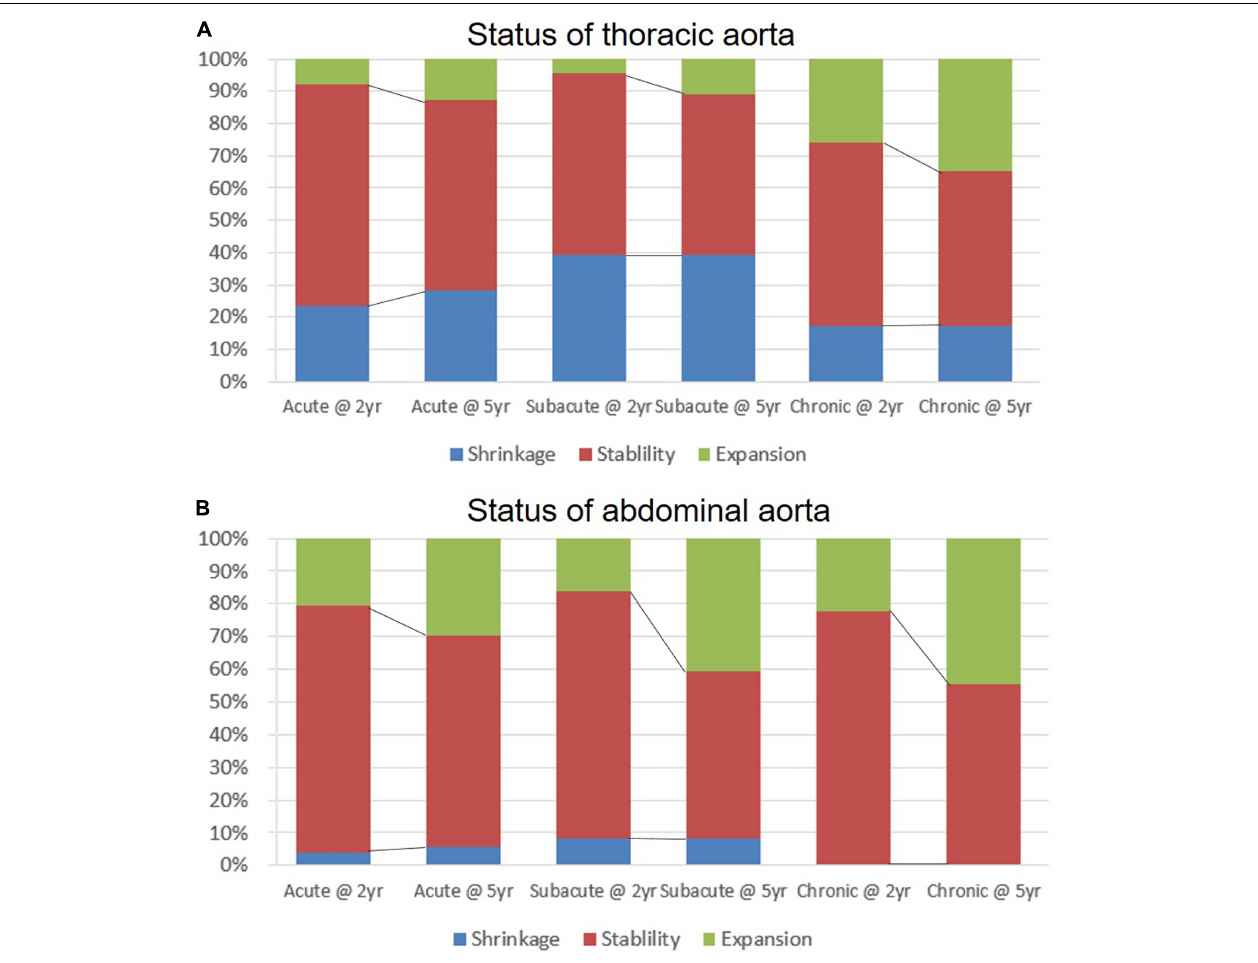
FIGURE 4 | The status of aortic remodeling in the thoracic and abdominal aorta over a 5-year follow-up period. The expansion, stable, or shrinkage status of maximum thoracic (A) and abdominal (B) aortic diameter observed in acute, subacute, and chronic type B aortic dissections (TBADs) during 5 years of follow-up is shown.